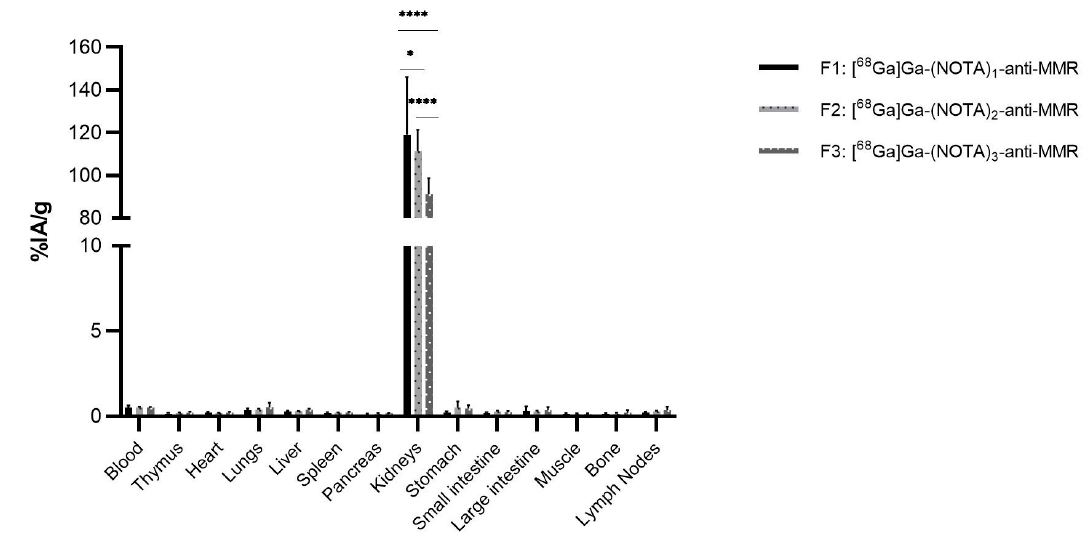
Figure 9. Ex vivo biodistribution analysis of [ 68 Ga]Ga-(NOTA) n -anti-MMR fractions in C57Bl/6 MMR KO mice ( n = 4, 5, 4 per group, respectively). (* p < 0.05, **** p < 0.001).